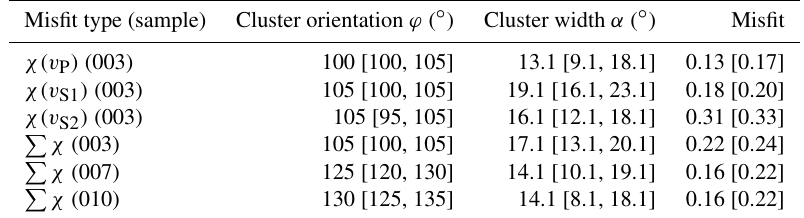
Figure 10. Misfit surfaces of seismic velocities showing fit to model parameters of the horizontal-cluster CPO for sample 003: (a) χ(v P ) , (b) χ(v S1 ) , (c) χ(v S2 ) and (d) χ(v P ) + χ(v S1 ) + χ(v S2 ) . Table 4. Best-fitting CPO model parameters and uncertainties informed by ultrasonic data. The notation (cid:80) χ = χ(v P ) + χ(v S1 ) + χ(v S2 ) is